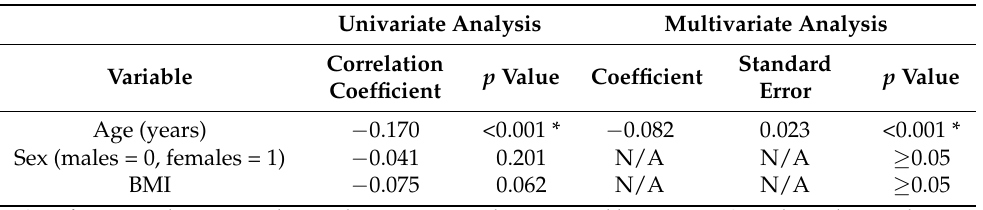
Table 2. Results of simple correlation and multiple regression analysis between SE and variables ( n = 416).